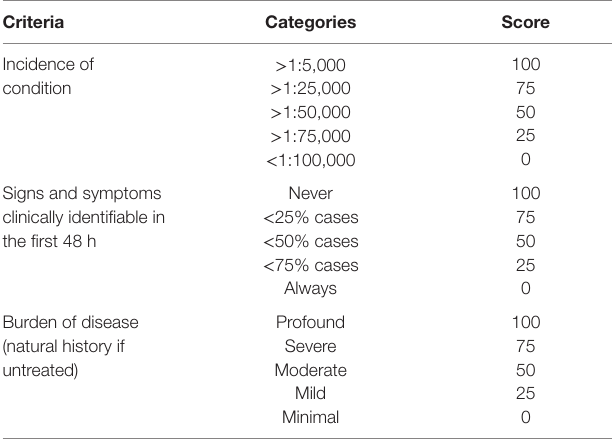
TABLe 1 | United States decision-making criteria used to assess aspects of the condition for newborn screening